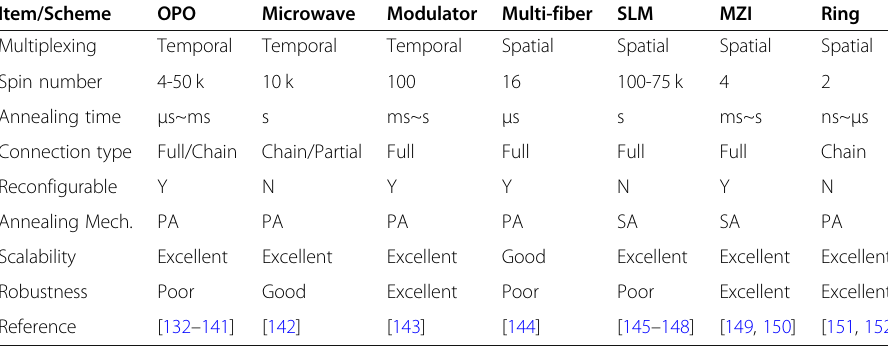
Table 1 Experimental data of different schemes shown in Fig. 5 a